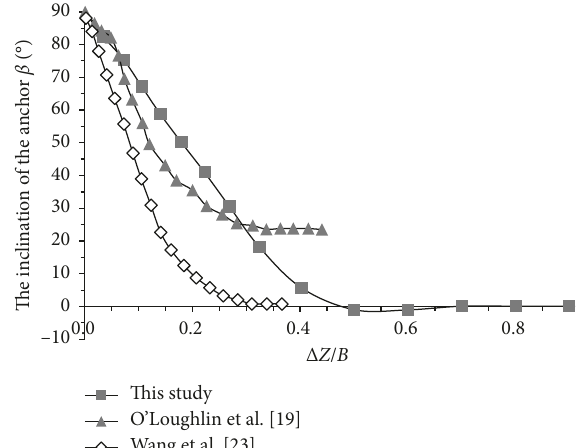
Figure 3: Comparison with test results by O’Loughlin et al. [19] and with the numerical results by Wang et al. [23] for normally consolidated soil.